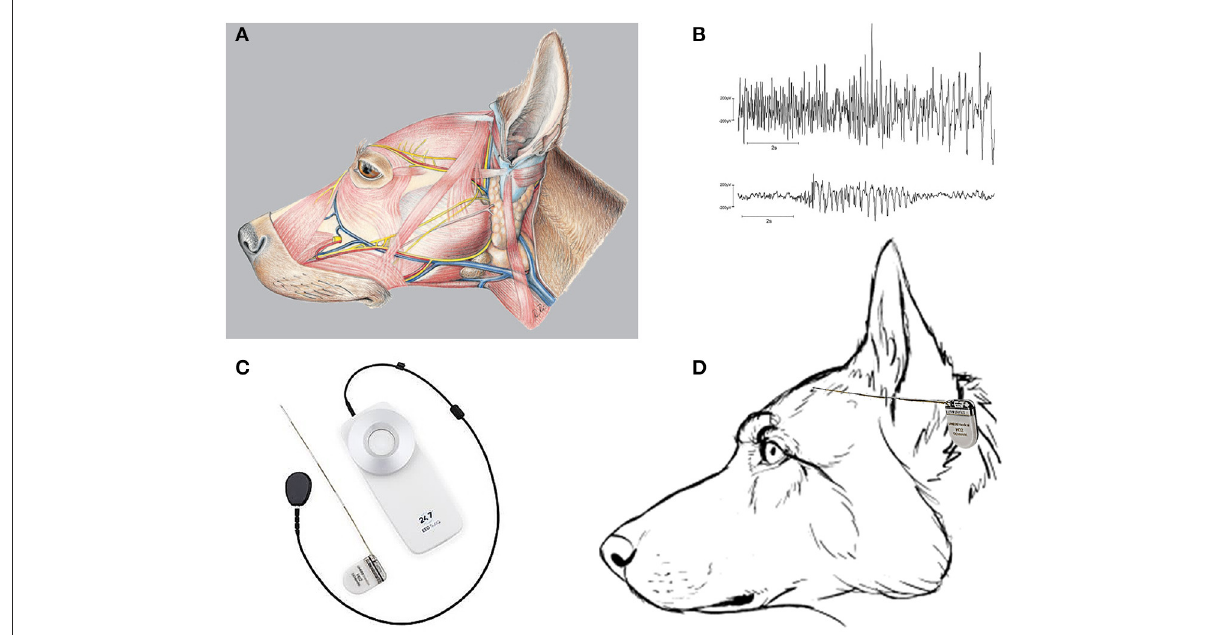
FIGURE1 The musculature of the dog’s head and seizure recording by a subscalp EEG device. (A) Illustrates the massive musculature of the dog’s head (see also Figure 2D), which produces artifacts when applying scalp EEG electrodes. The picture was taken from Reese et al. (15). (B) Two different EEG seizures were recorded from Beagle dogs with subscalp electrodes inserted below the temporalis muscle on the skull to minimize electromyographic artifacts [from Authier et al. (16)]. EEG data were obtained using telemetry transmitter leads with bipolar derivations according to the internationally standardized 10–20 system, using Cz-Oz derivations as previously described (17). (C) The 24/7 EEG TM SubQ system from UNEEG Medical (Lillerød, Denmark), involving a small ceramic implant that consists of an electrode house containing an inductive coil for the transfer of power and data and a wire with three leads (electrodes). The center electrode is used for reference, and the recordings, therefore, have two bipolar channels. An external device supplies the implant with power, receives and stores the measured EEG signals, and when coupled with a smartphone can wirelessly stream the recorded EEG data automatically to a cloud environment. (D) Schematic illustration of how the 24/7 EEG TM SubQ system may fit to the size of a dog’s head. The device will be tunneled under the temporalis muscle and proximate to the dog’s skull (not illustrated; see